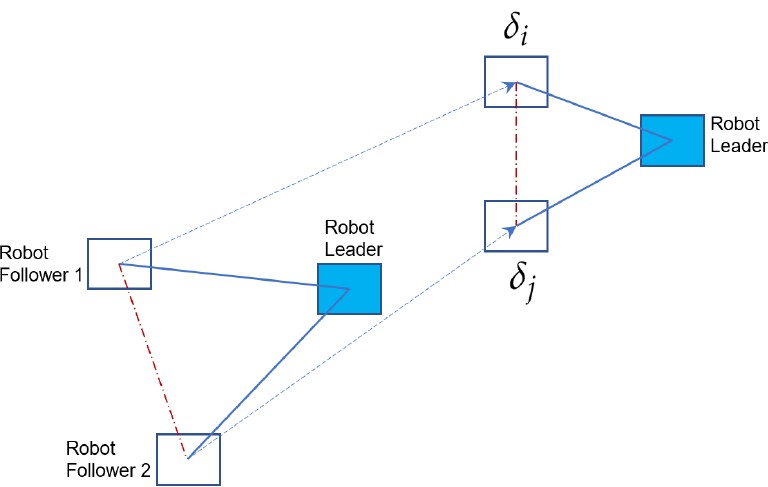
Figure 2. Illustration of a robot moving to make a formation. The dashed red line indicates that there is no information sharing between the two follower robots.